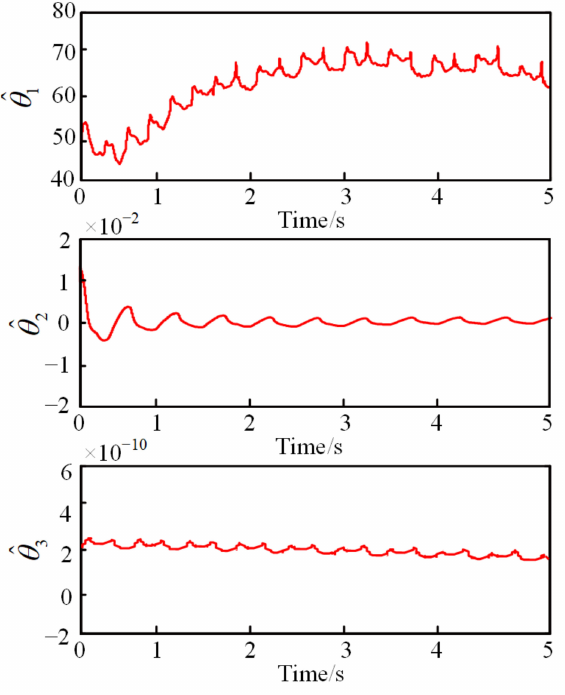
Figure 7. Parameter estimation of the adaptive backstepping